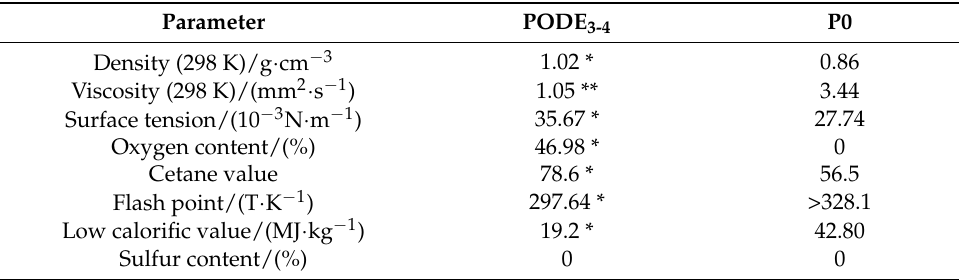
Table 4. Physical and chemical parameters of various fuel blends used in the